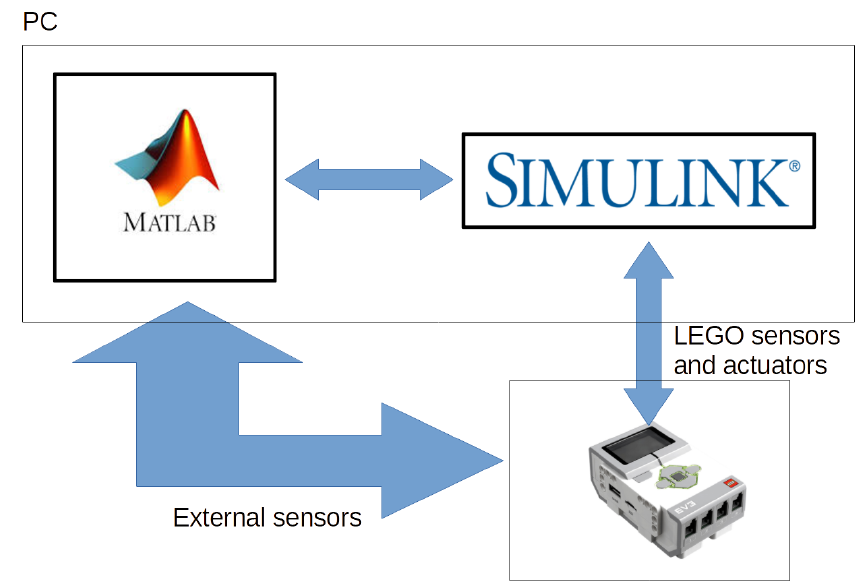
Figure 3. Linking